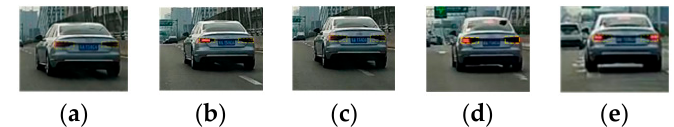
Figure 19. Brightness change chart of the direction light during on and off process.